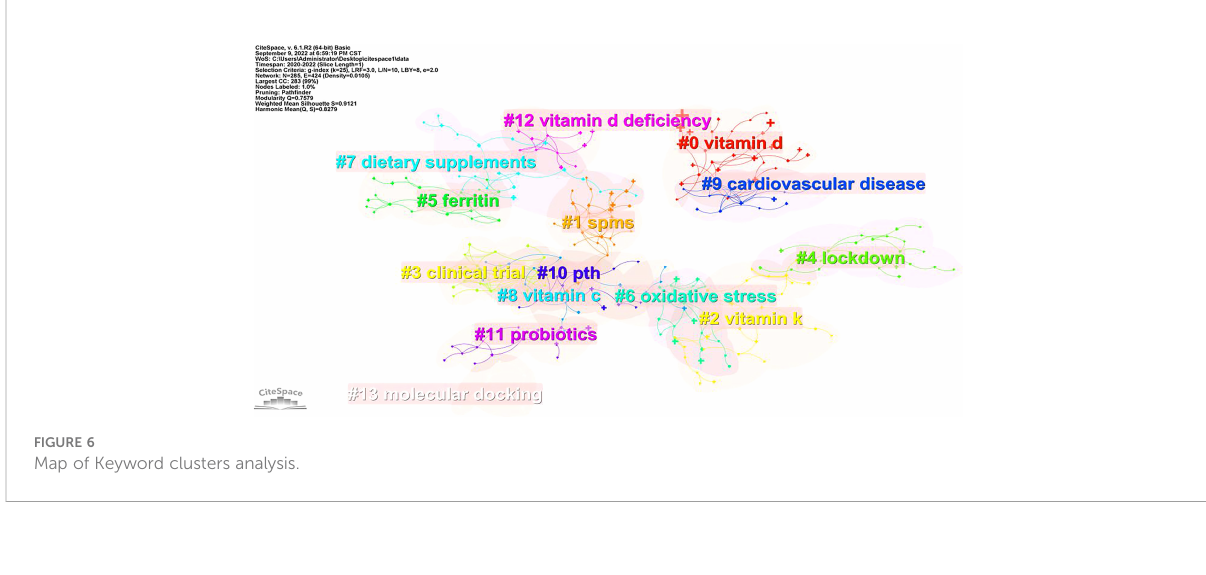
FIGURE 6 Map of Keyword clusters analysis.